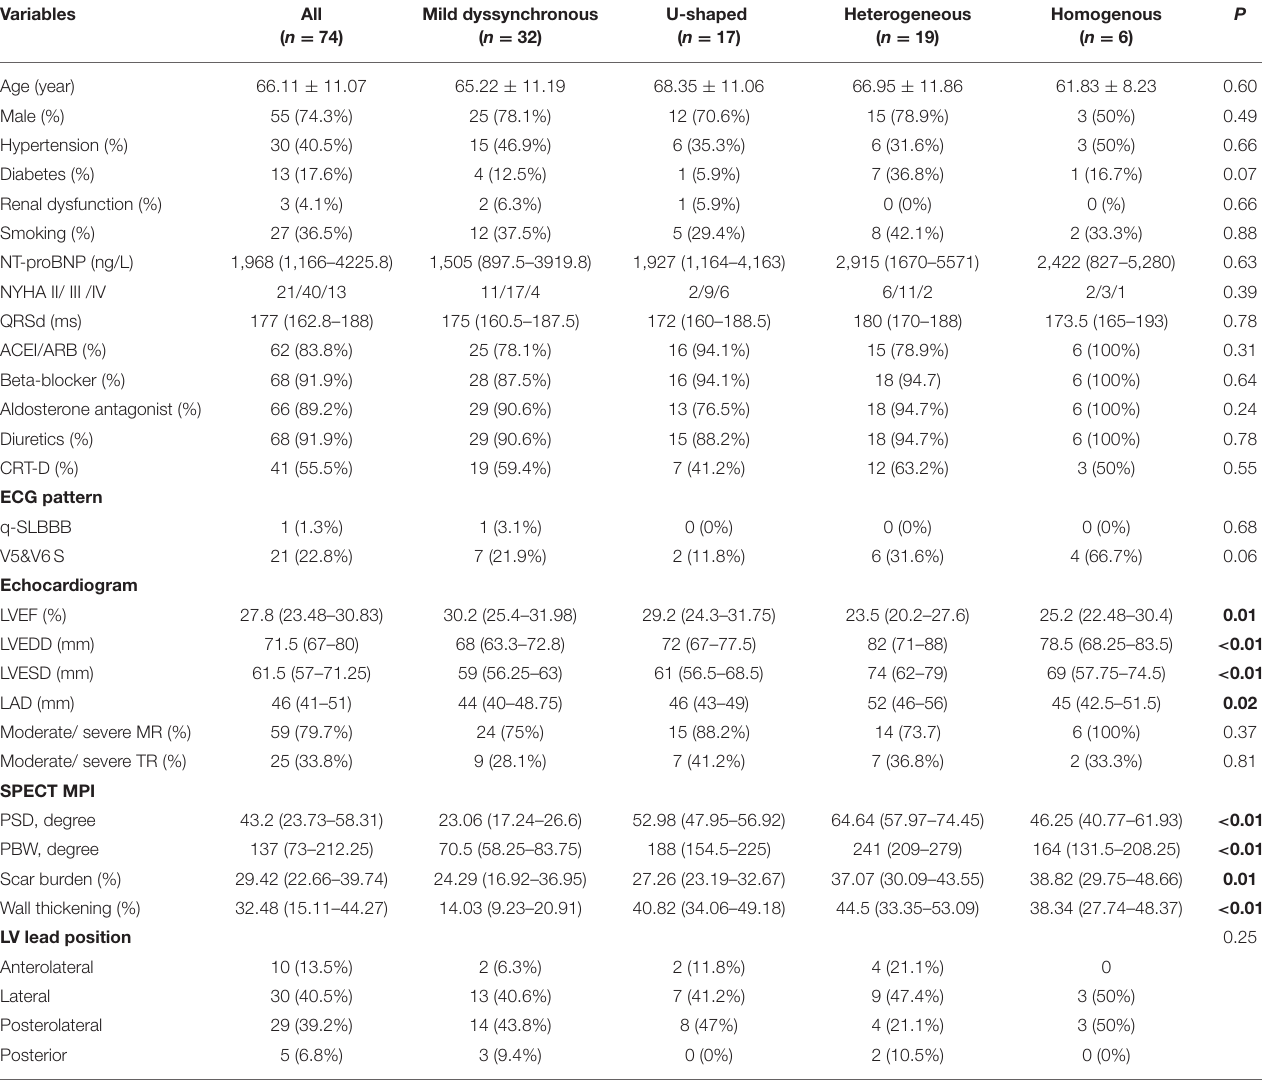
TABLE 1 | Baseline characteristics of 74 patients with